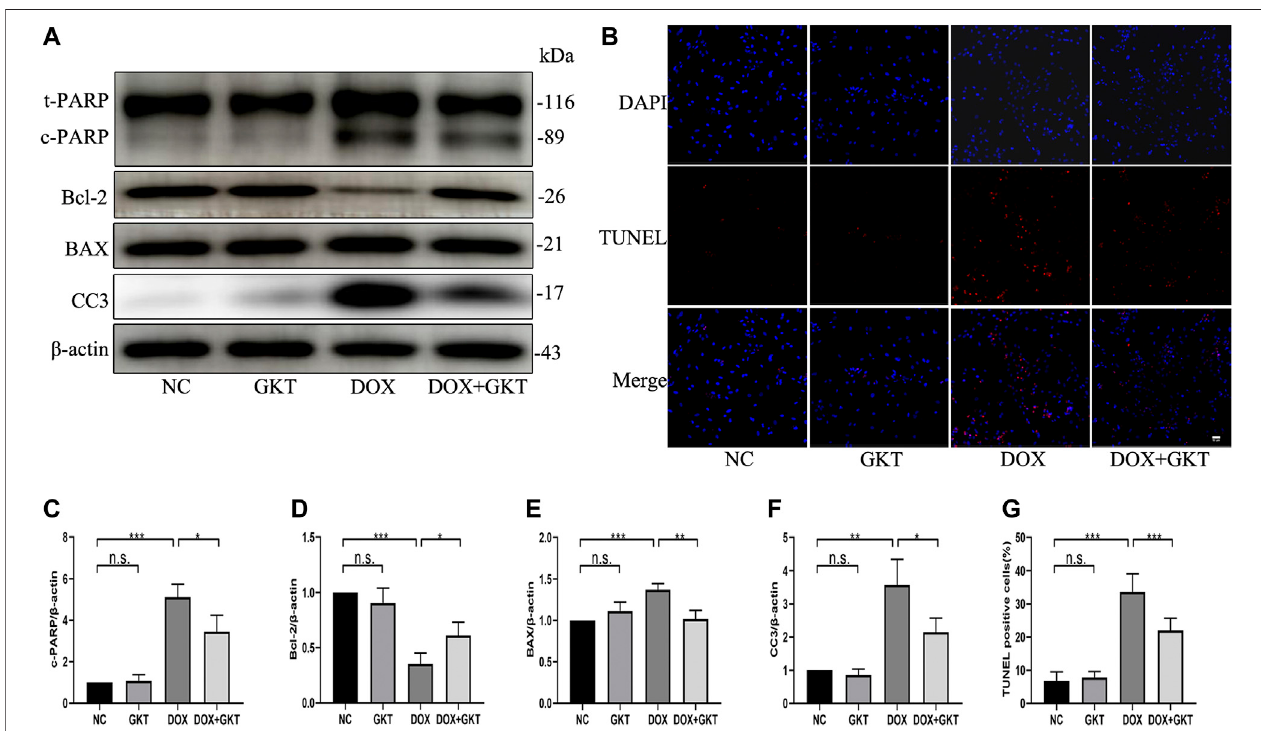
FIGURE 6 | GKT137831 reduced DOX-induced apoptosis of NRCMs. (A) Representative western blot analysis of c-PARP, Bcl-2, BAX, and CC3 and quanti fi cations bydensitometric analysis (C,D,E,F) , β -actinwasusedasaloadingcontrol( n =3). (B,G) RepresentativeimagesofTUNELstaininginNRCMs (scalebar = 50 μ m) and related quanti fi cation ofTUNELstaining( n =3). NRCMswere pretreated withGKT (5 μ M) for 1 h, and then treated withDOX (2 μ M) for24 h. * p < 0.05, ** p < 0.01, *** p < 0.001, n. s., not signi fi cant. DOX, doxorubicin; GKT, GKT137831; c-PARP, cleaved PARP; CC3, cleaved caspase